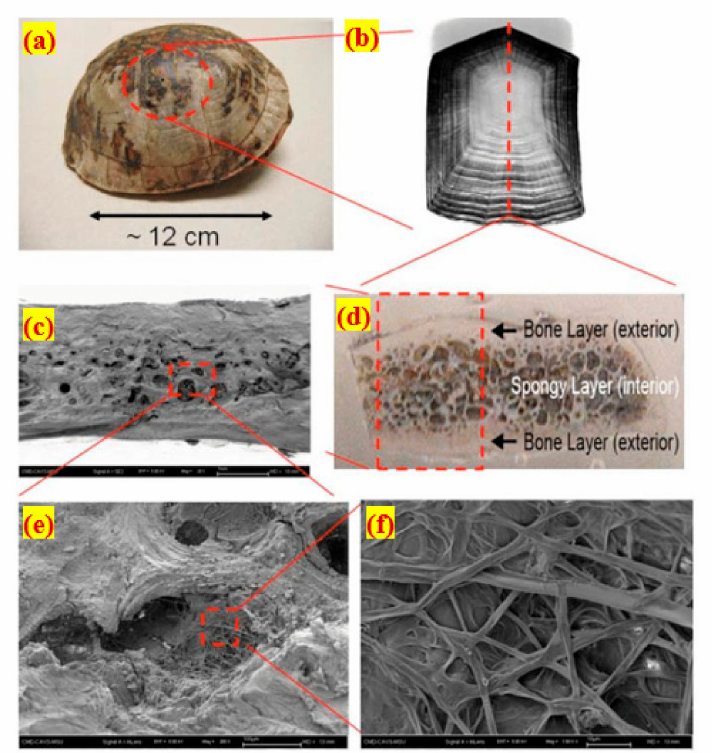
Figure 1. Multiscale hierarchy and the shell of the turtle: ( a ) a morphology of the turtle shell, ( b ) a costal scute showing the growth pattern’s ( c ) surface fracture in SEM, ( d ) a view of the carapace’s inside showing the composite layer, ( e ) SEM of the cell structure, and ( f ) SEM of the cell’s internal fibrous